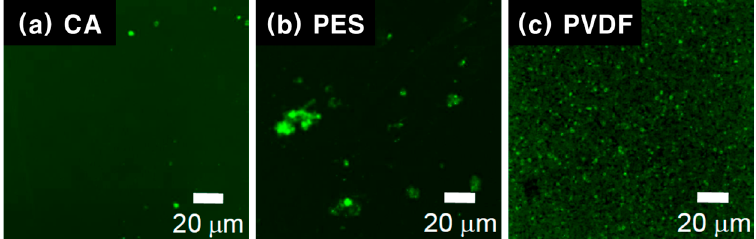
Figure 5. Confocal laser scanning microscope (CLSM) images obtained for the surfaces of thin films of ( a ) CA; ( b ) PES; and ( c ) PVDF after use in batch attachment tests with activated sludge. The surfaces of the films were stained with LIVE/DEAD stain.